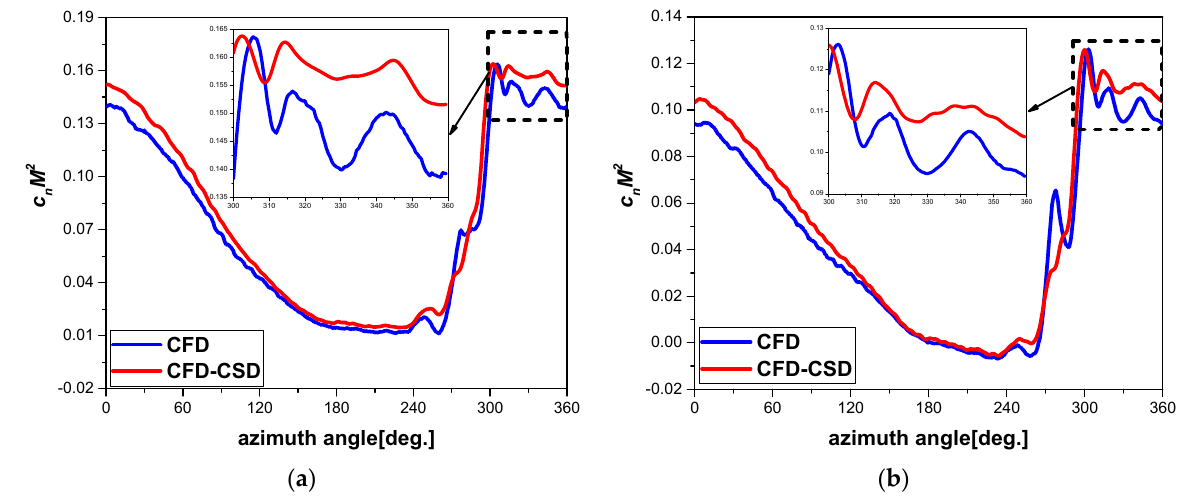
Figure 19. Comparison of normal force coe ffi cient for τ = − 5° obtained from the CFD and coupled CFD-CSD methods. ( a ) r/R = 0.9. ( b ) r/R = 0.95.